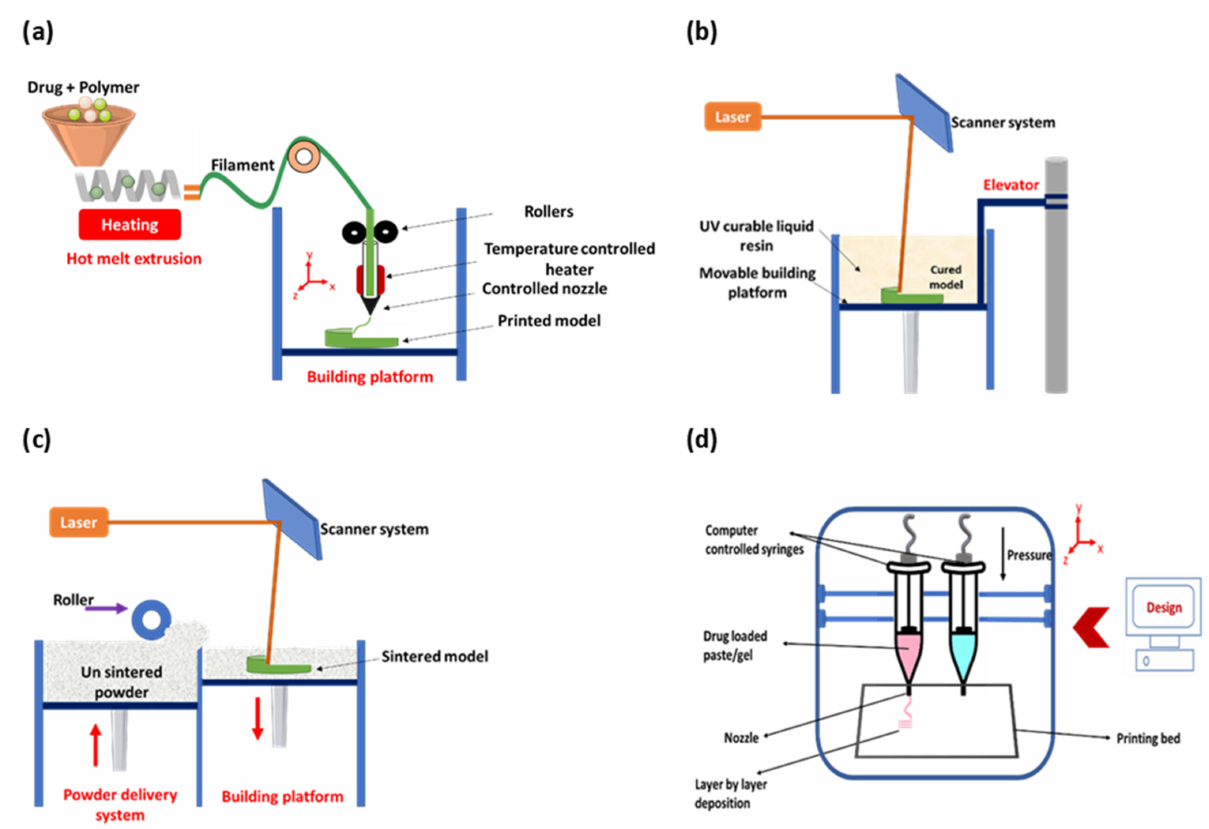
Figure 3. A schematic diagram ( a ) showing the different parts of the FDM printer: filament spool, heated printer nozzle, and printing platform; ( b ) showing the different parts of the SLA printer: laser/UV source, resin tray, and printing platform; ( c ) showing the different parts of the SLS printer: powder roller, laser beam source, laser scanner, and fabrication piston; and ( d ) showing the different parts of the SSE printer: syringes, nozzle, and printing